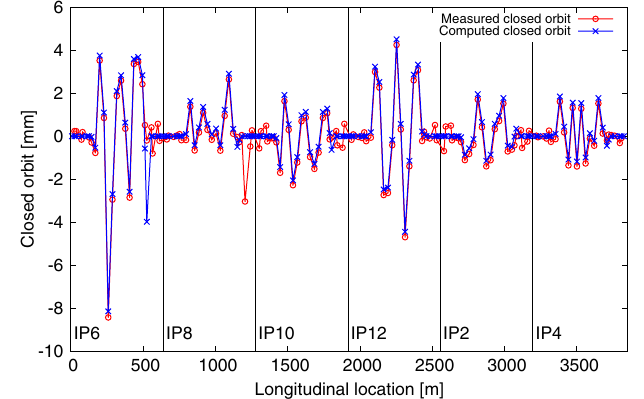
FIG. 11. Measured and computed horizontal closed orbit for correction of arc beta-beat in the Yellow ring. A maximum excursion of 8.5 mm was observed in the arc between IP6 and